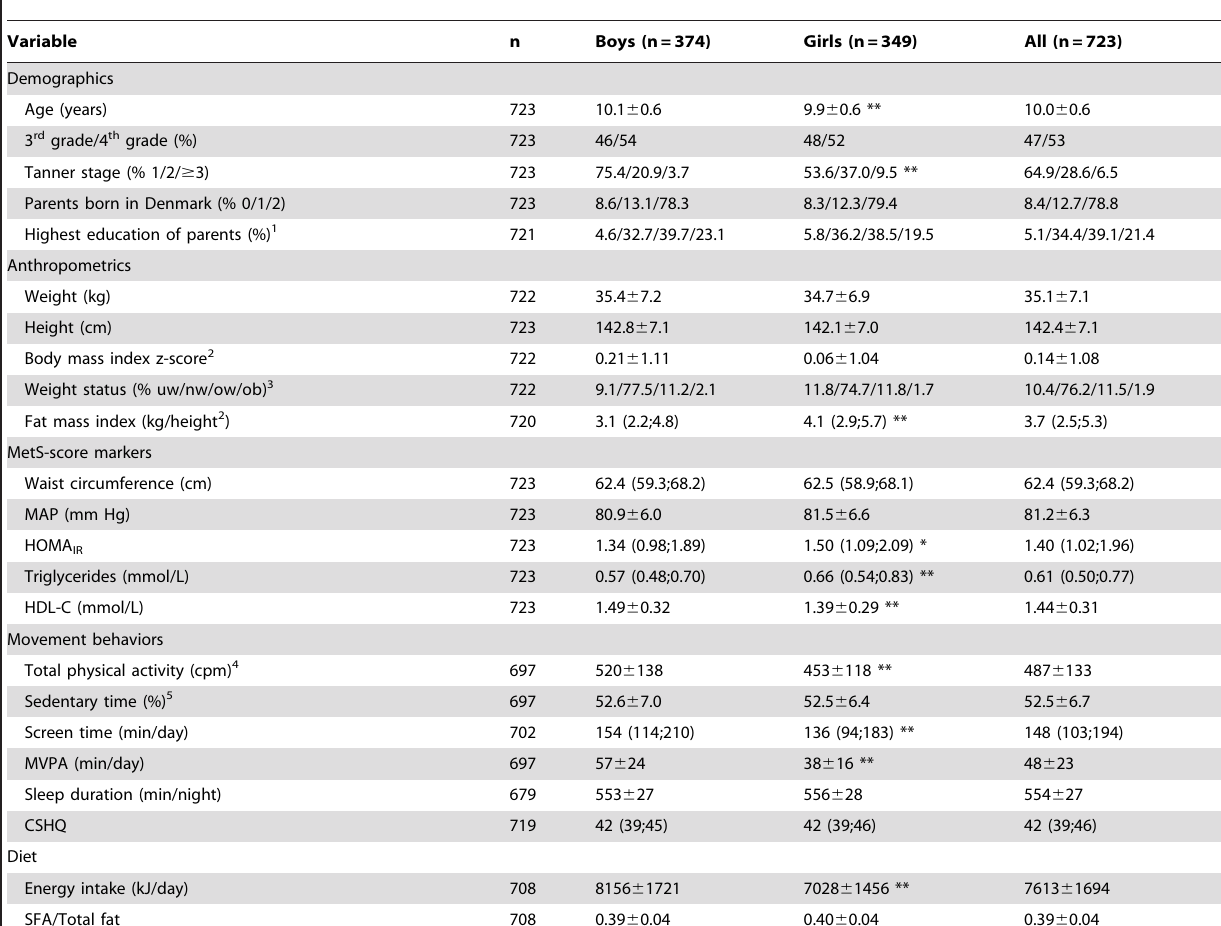
Table 1. Baseline descriptive characteristics of the study population stratified by sex.